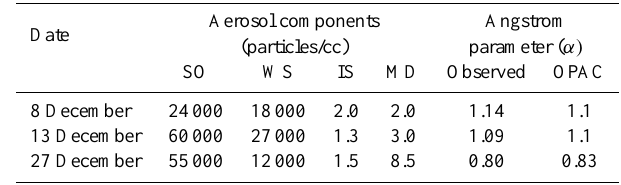
Table 2. Aerosol components, viz., Soot (SO), Water Soluble (WS), Water Insoluble (IS) and Mineral Dust (MD) are estimated from OPAC model fitting of the observed aerosol optical depth (AOD) spectra. The Angstrom Parameter ( α) estimated for the observed as well as the fitted AOD spectra are